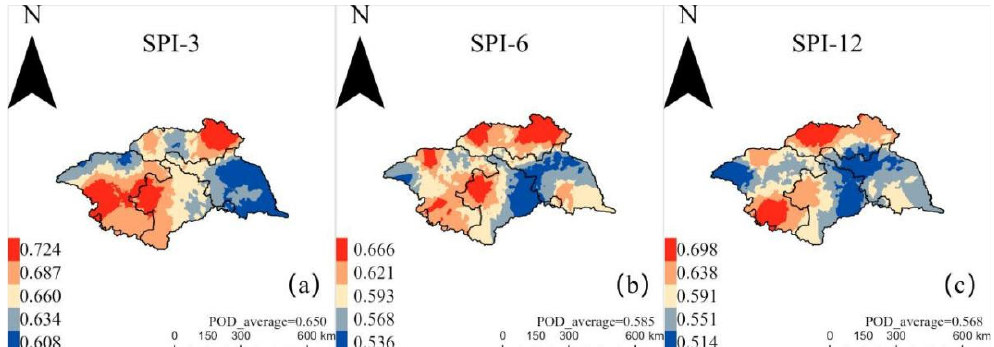
Figure 8. The spatial distribution of POD for ( a ) SPI ‐ 3, ( b ) SPI ‐ 6, and ( c ) SPI ‐ 12.